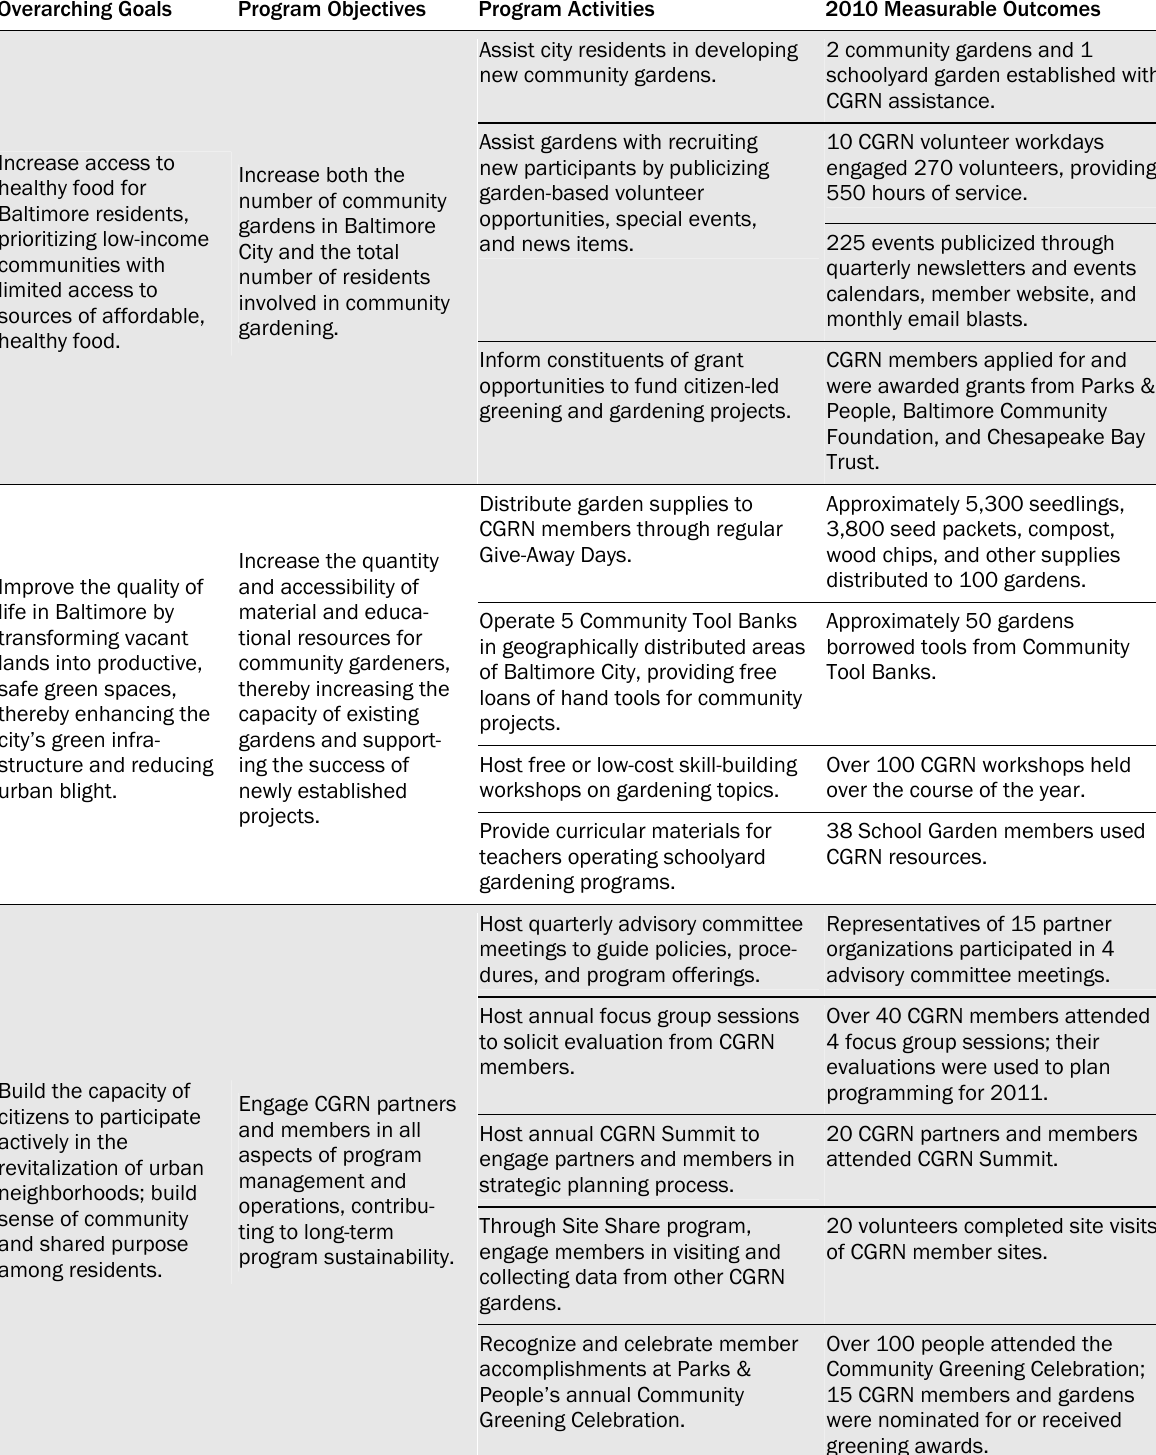
Figure 1. CGRN Goals, Objectives, Program Activities, and Measurable Outcomes in